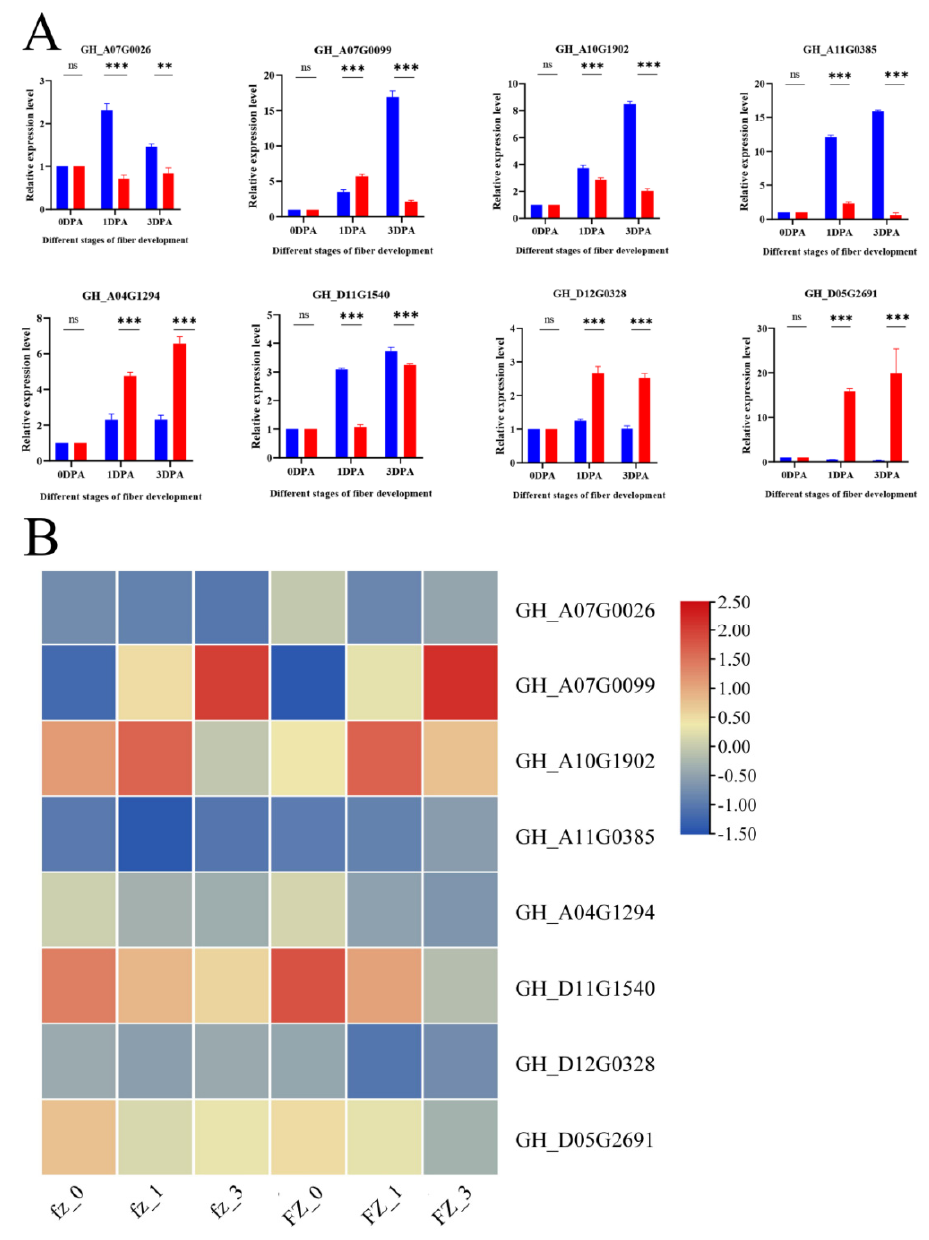
Figure 6. RNA-Seq results were confirmed using qRT-PCR experiments. ( A ) qRT-PCR results of eight genes. Relevant significance level ( p -value) shown above each histogram. ns indicates no significant effect at p < 0.05; ** and *** represent significance at p < 0.01 and p < 0.001 levels, respectively. Pink bars, L; blue bars, S. ( B ) RNA-Seq heatmap of eight genes.